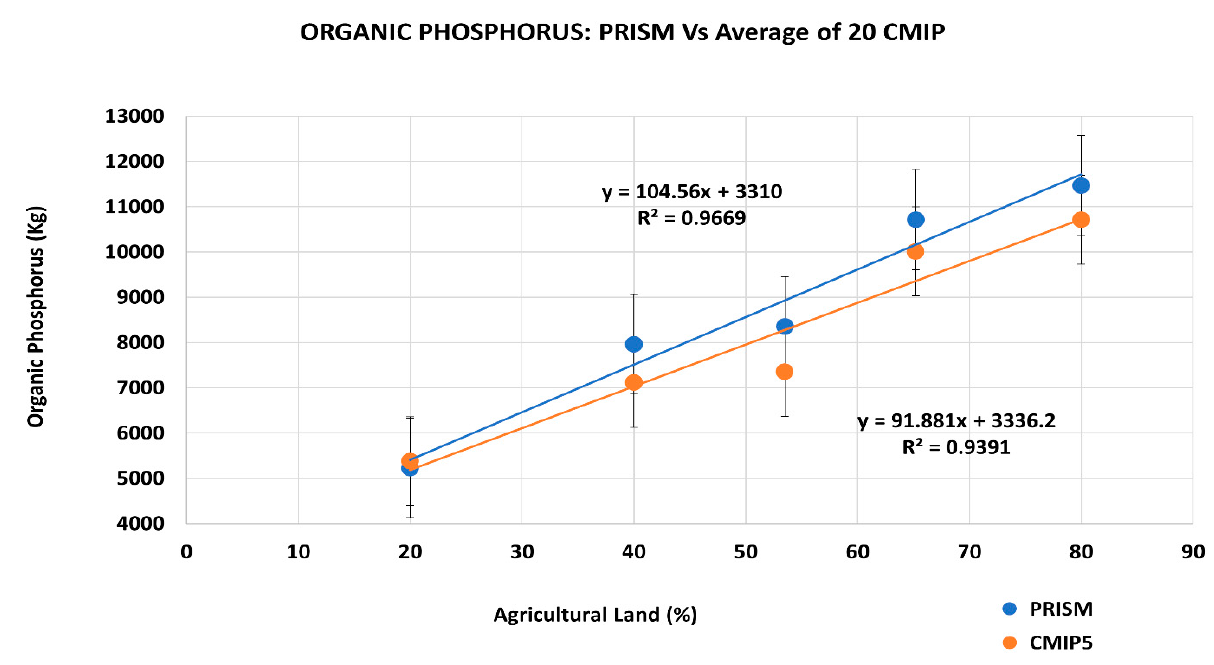
Figure 6. PRISM vs. 20 CMIP5 GCMs for organic phosphorus.